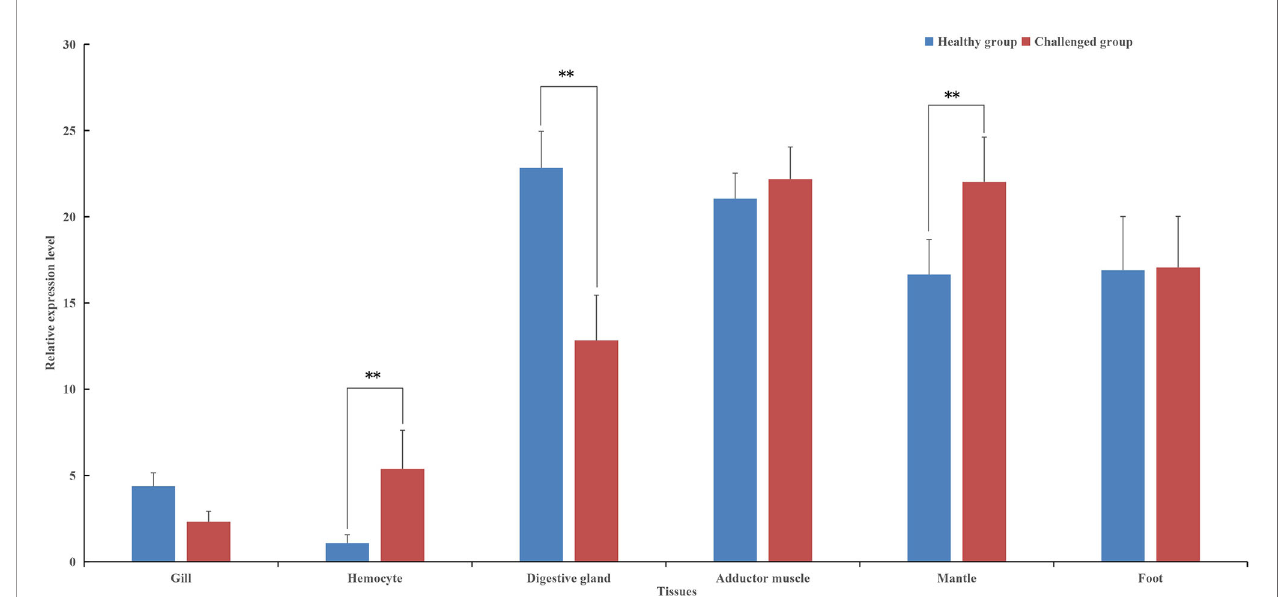
FIGURE 3 | The tissue-speci fi c expression of pf-C3 was detected by Real-time PCR. Signi fi cant difference was indicated by asterisks, ** P <